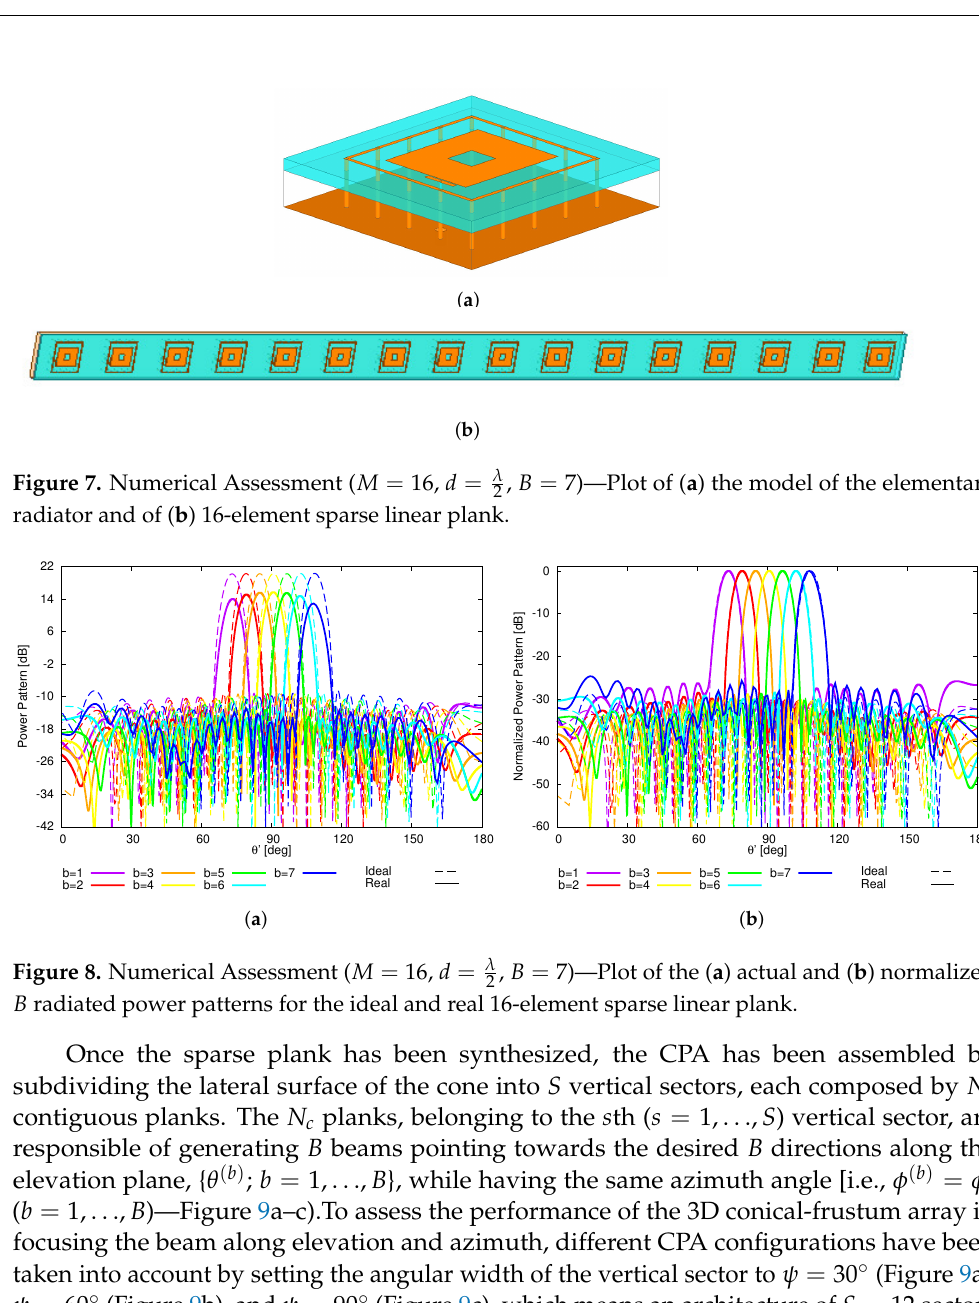
, B = 7)—Plot of the ( a ) actual and ( b ) normalized 2